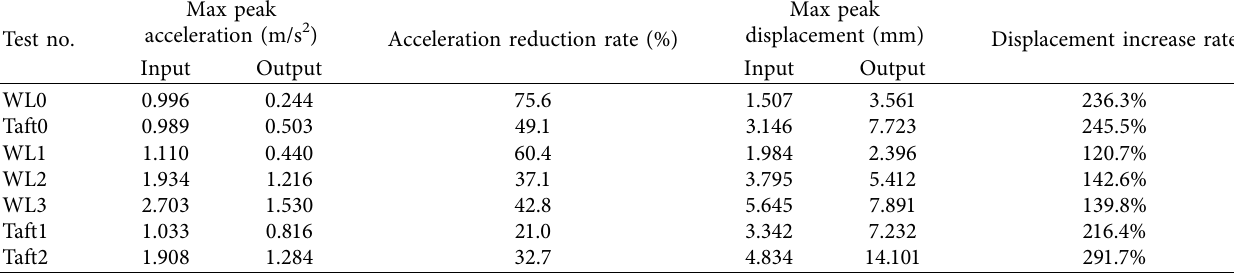
Table 3: Details of max peak acceleration and displacement.